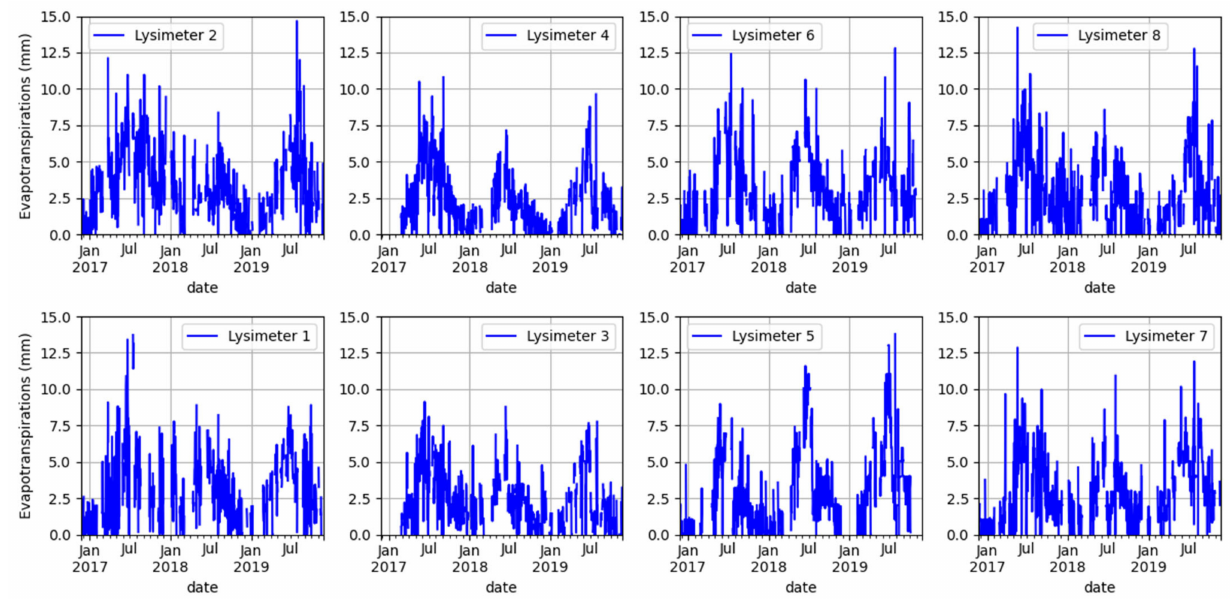
Figure 5. Daily evapotranspiration (ET) validated for all